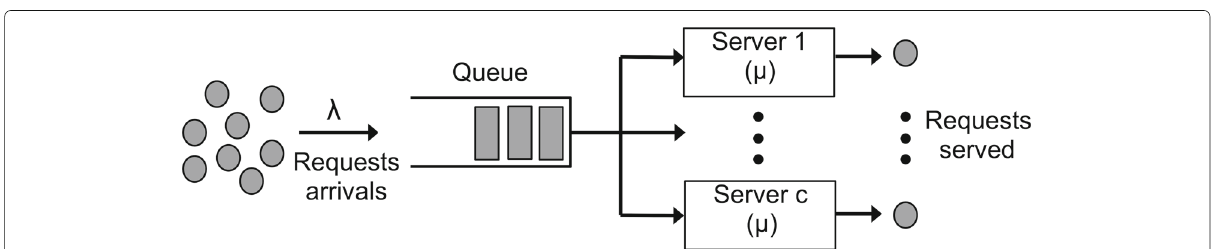
Fig. 2 M/M/c queue model for the distributed server.This is a graphical representation of a M/M/c queue model, with c parallel servers ( c > 1), each serving user requests. All requests reaching the system join a single queue, and they are served in their order of arrival. λ is the arrival rate, i.e., the average number of requests that reach the system per time unit, modeled as a Poisson distribution. μ is the service rate, i.e., the average number of requests that a server can process per time